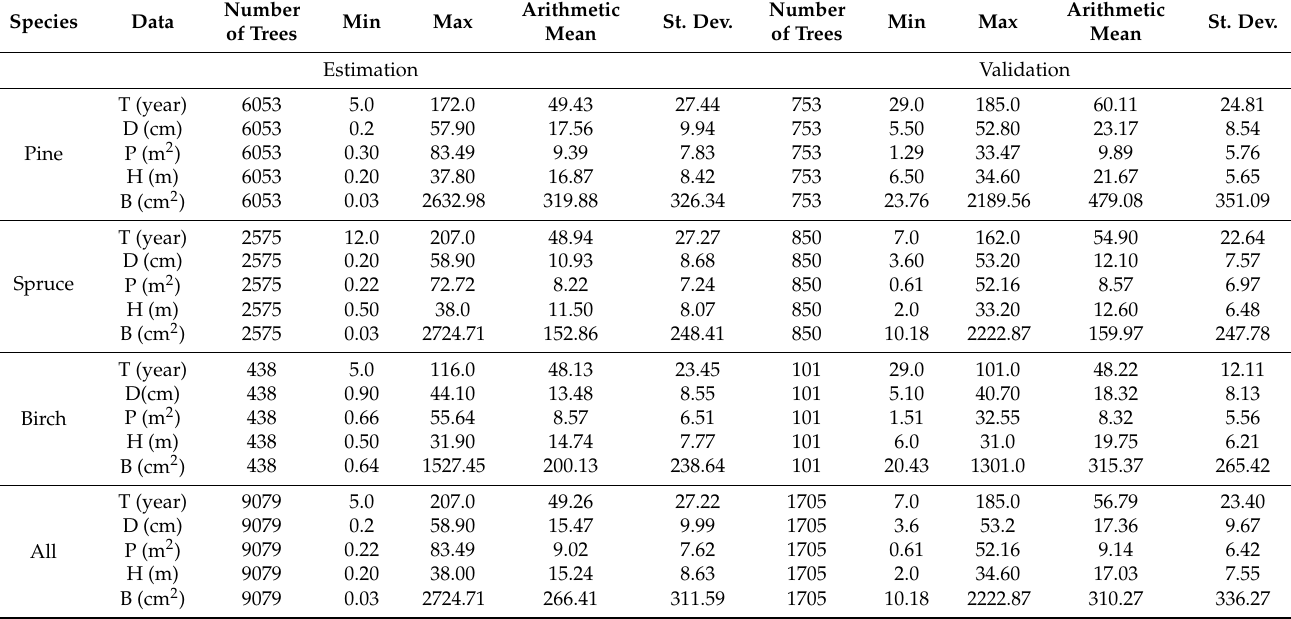
Table 1. Tree summary statistics for model estimation and validation datasets